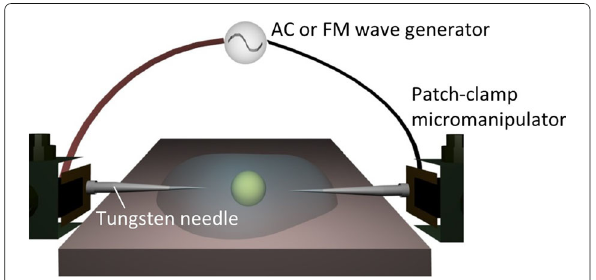
Fig. 1 Experimental setup. A schematic of the dielectrophoretic manipulation system illustrating the AC or FM electric field applied to a target particle via a pair of electrode needles controlled by patch-clamp micromanipulators